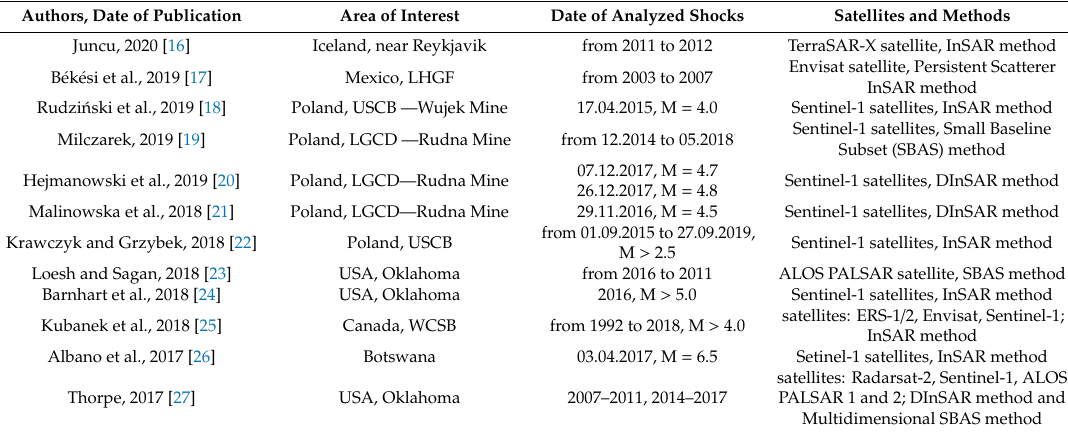
Table 1. Studies of terrain deformations caused by seismicity induced by underground extraction of resources using satellite radar interferometry.